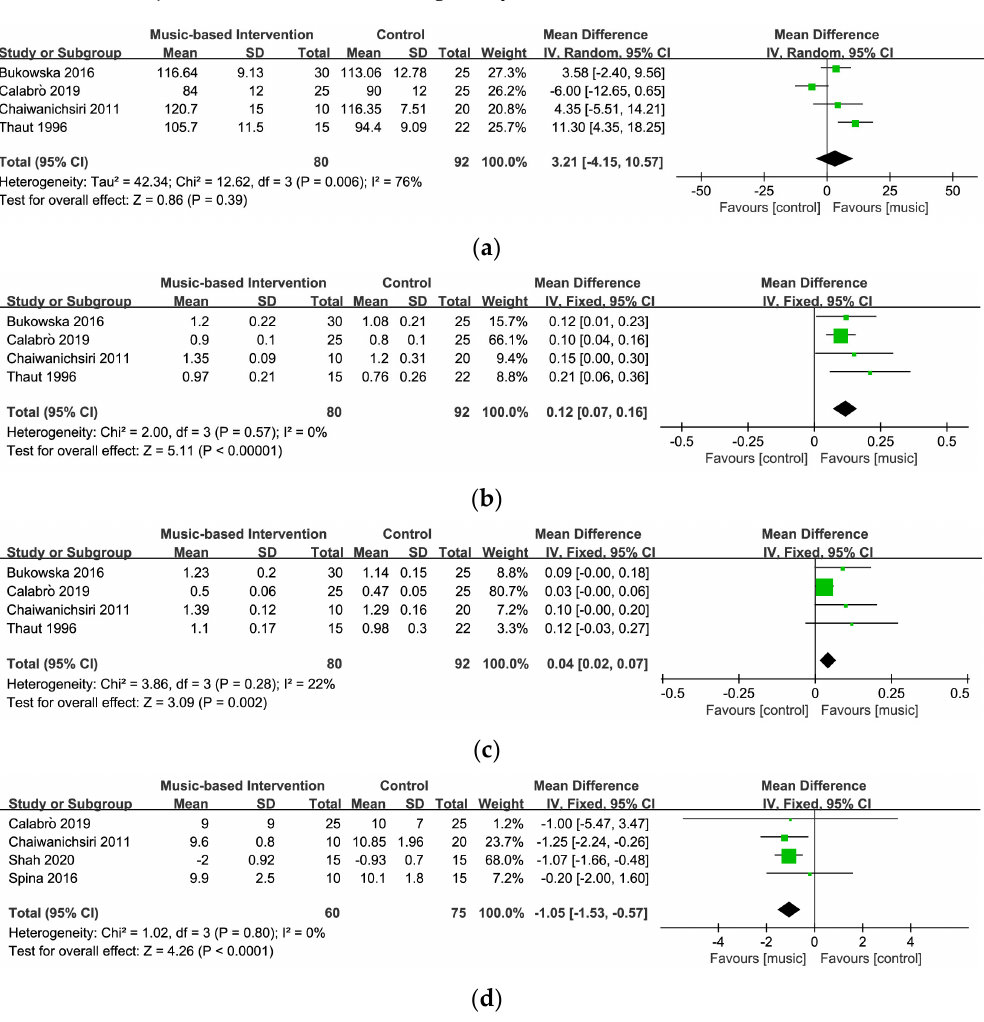
Figure 4. Forest plots for ( a ) cadence [26,27,55,56], ( b ) velocity [26,27,55,56], ( c ) stride length [26,27,55,56], and ( d ) mobility [26,30,39,56].